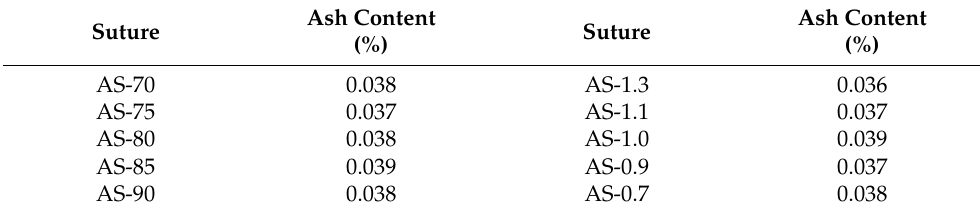
Figure 5. SEM images of chitosan (with different DD) monofilaments with enzymatic hydrolysis for five weeks. The effects of the chitosan’s M V on the residual ratio and BSR of its monofilament with enzymatic hydrolysis are shown in Figure 6. It looked as though the difference on the residual ratio for all monofilaments was not obvious, but the BSR of the monofilament decreased quickly with the decreasing of the M V of the chitosan. After degradation for 5 weeks, the BSR of AS-1.1 & AS-1.3 were more than 70% and suitable as sutures. Figure 7 shows the SEM images of chitosan (with different M V ) monofilaments with enzymatic hy- drolysis for five weeks. With the decreasing of the M V of the chitosan, the surface of its monofilament bestrewed more depressions and pores, but AS-1.0, AS-1.1, and AS-1.3 looked smoother. Figure 6. Effects of chitosan’s M V on residual ratio ( a ) and BSR ( b ) of its monofilament with enzy- matic hydrolys.